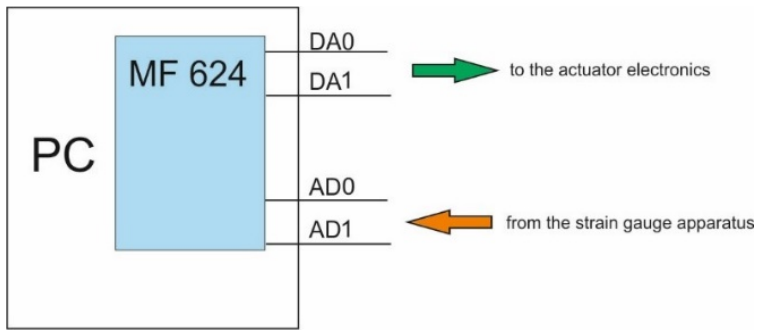
Figure 9. Display of input and output signals to the card.